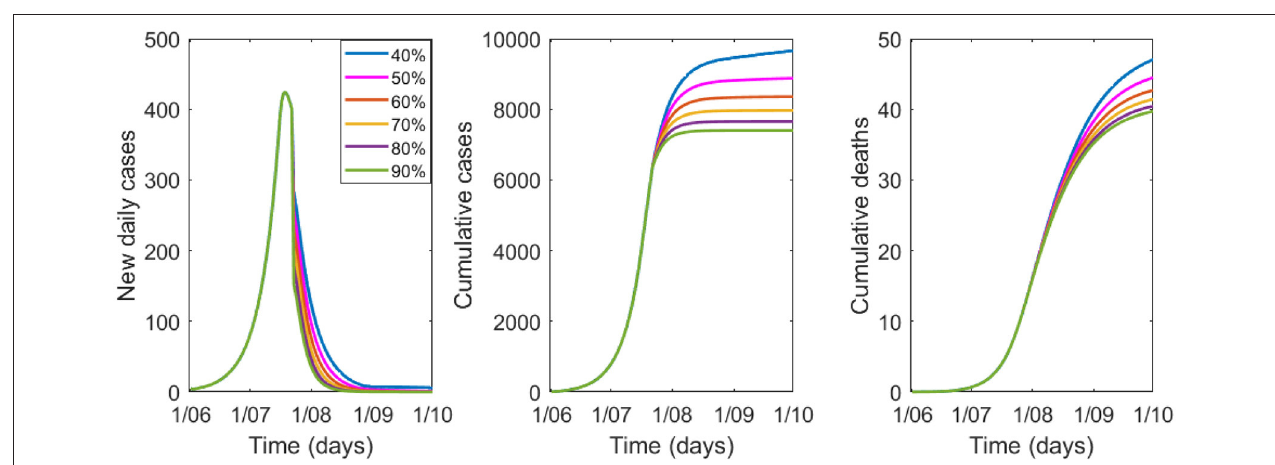
FIGURE 3 | Variation in epidemic control for COVID-19 by percentage of people wearing masks from 40 to 90%, with a mask efficacy of 67%.